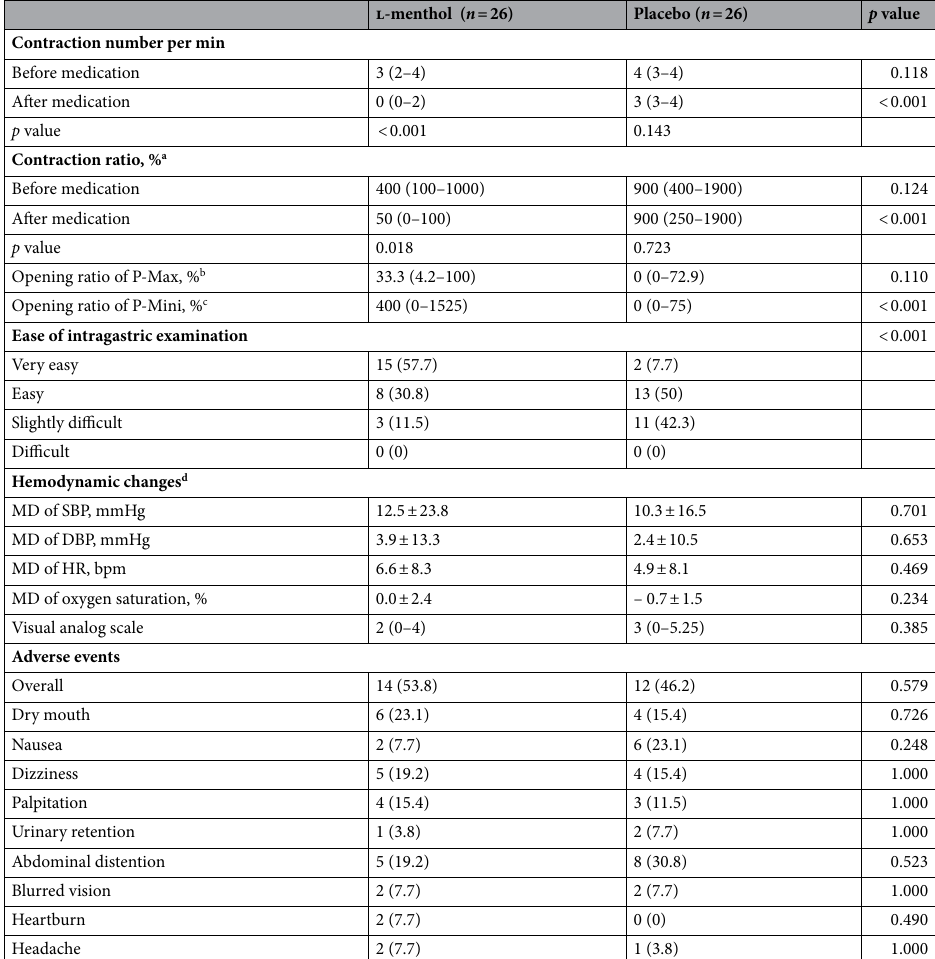
Table 3. Comparison of contraction parameters, ease of intragastric examination, hemodynamic changes, visual analogue scale and adverse events between the two groups. Values are median (interquartile range), mean ± standard deviation, or n (%). DBP diastolic blood pressure, HR heart rate, MD mean difference, SBP systolic blood pressure. a Contraction ratio, % = (maximal pyloric ring diameter − minimal pyloric ring diameter) ÷ minimal pyloric ring diameter × 100. b Opening ratio of P-Max, % = (maximal pyloric ring diameter after medication − maximal pyloric ring diameter before medication) ÷ maximal pyloric ring diameter before medication × 100. c Opening ratio of P-Mini, % = (minimal pyloric ring diameter after medication − minimal pyloric ring diameter before medication) ÷ minimal pyloric ring diameter before medication × 100. d Mean difference = the mean of (max SBP or DBP or HR or oxygen saturation after medication − baseline SBP or DBP or HR or oxygen saturation before